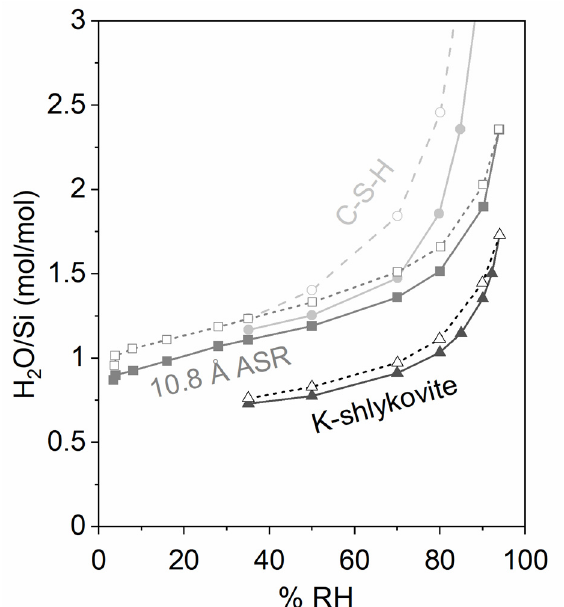
Figure 13. Sorption and desorption (dashed lines) isotherm for the ASR products formed at 80 °C (K ‐ shlykovite), 40 °C (10.8 Å), and a reference sample of calcium ‐ silicate ‐ hydrate (C ‐ S ‐ H with Ca/Si ratio of 1.6) from 3 to 94 % RH. Adapted from [64].